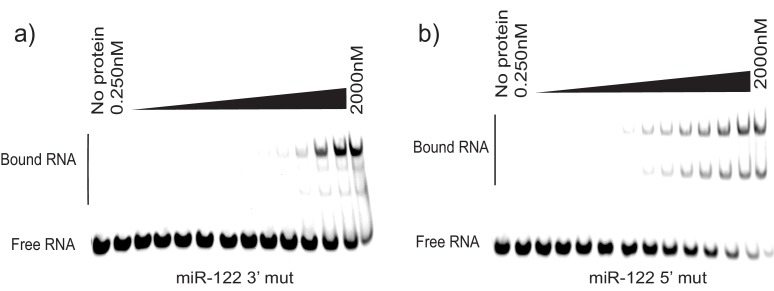
EMSA for miR-122 mutated versions.(a) miR-122 3’ mutated oligonucleotide incubated with increasing amounts of La. (b) miR-122 5’ mutated oligonucleotide incubated with increasing amounts of La.